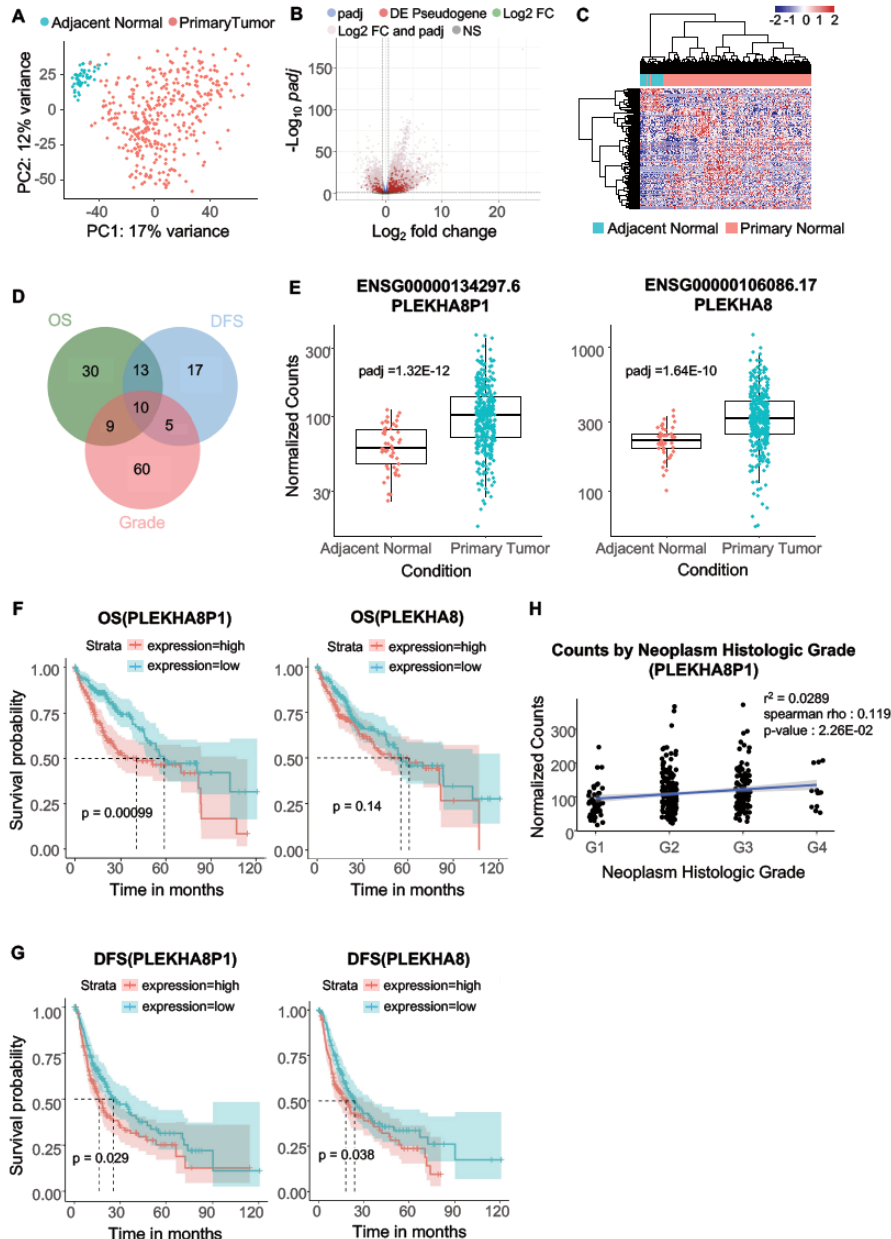
Figure 1. Identification of differentially expressed pseudogene with clinical implications in liver cancer. ( A ) Principal component analysis (PCA) plot of 369 primary liver tumor samples (red) and 49 adjacent normal samples (blue). ( B ) Significantly differentially expressed pseudogenes are marked in red in volcano plot. ( C ) Hierarchical clustering analysis of 465 significantly dysregulated pseudogenes in primary liver tumors (red) and adjacent normal tissues (blue). ( D ) Overlap between differentially expressed pseudogenes based on association with three clinical features (OS, DFS, histologic grade). ( E ) Expression of PLEKHA8P1 (left panel) and PLEKHA8 (right panel) in primary liver tumors (red) and adjacent normal tissues (blue). ( F , G ) Kaplan–Meier survival curves of PLEKHA8P1 (left panel) and PLEKHA8 (right panel) associated with overall survival and disease‐free survival. ( H ) Correlation analysis between PLEKHA8P1 expression level and the neoplasm histologic grade. Blue line is the regression line, and the gray shadow indicates the confidence interval.